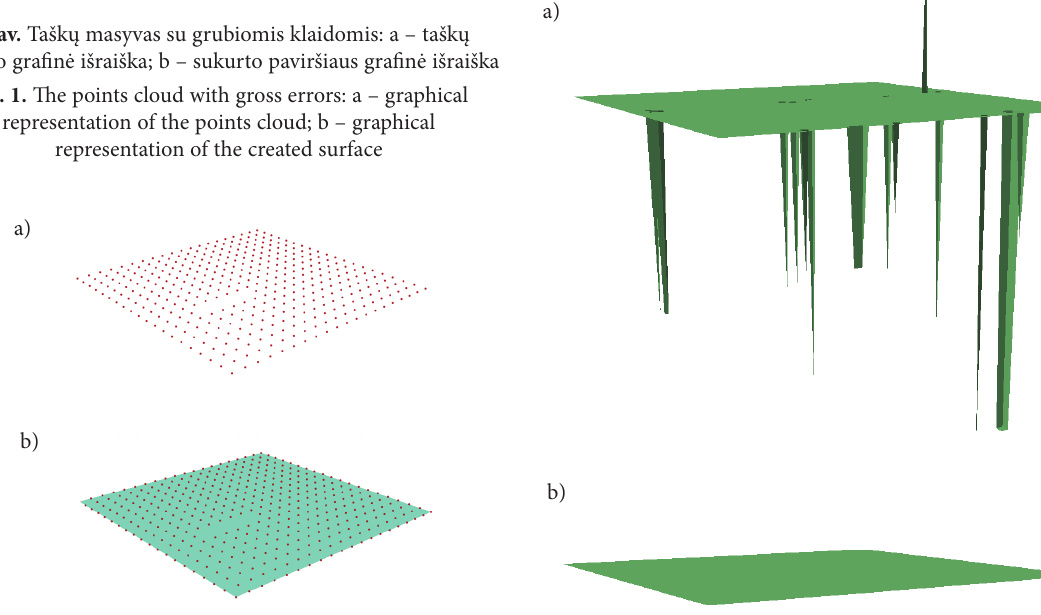
Fig. 3. Graphical representation of the points cloud of the horizontal plane: a – with gross errors; b – after analysis and elimination of gross